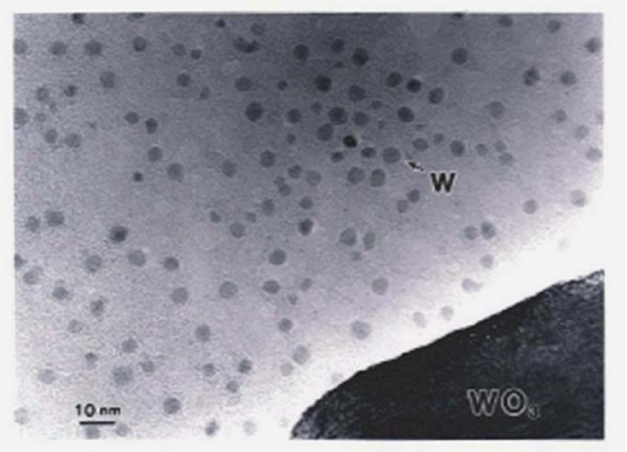
Figure 21. W nanoparticles deposited by electron beam irradiation of a WO 3 particle at 4 × 10 23 e/cm 2 s (6 × 10 8 A/m 2 ) for a few seconds. The diameter of the W particles ranged between 2 and 6 nm with an average of 4.3 nm [16].